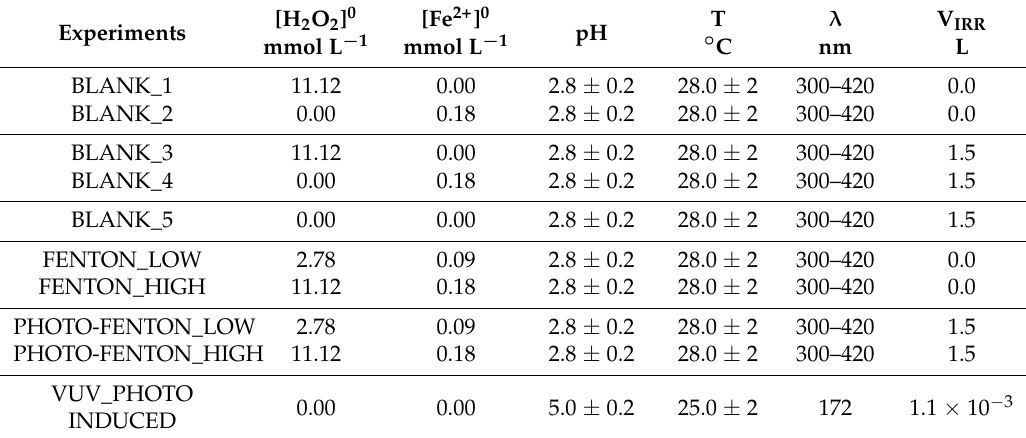
Table 1. Design of experiments performed for an initial PCT concentration of [PCT] 0 = 0.26 mmol L −